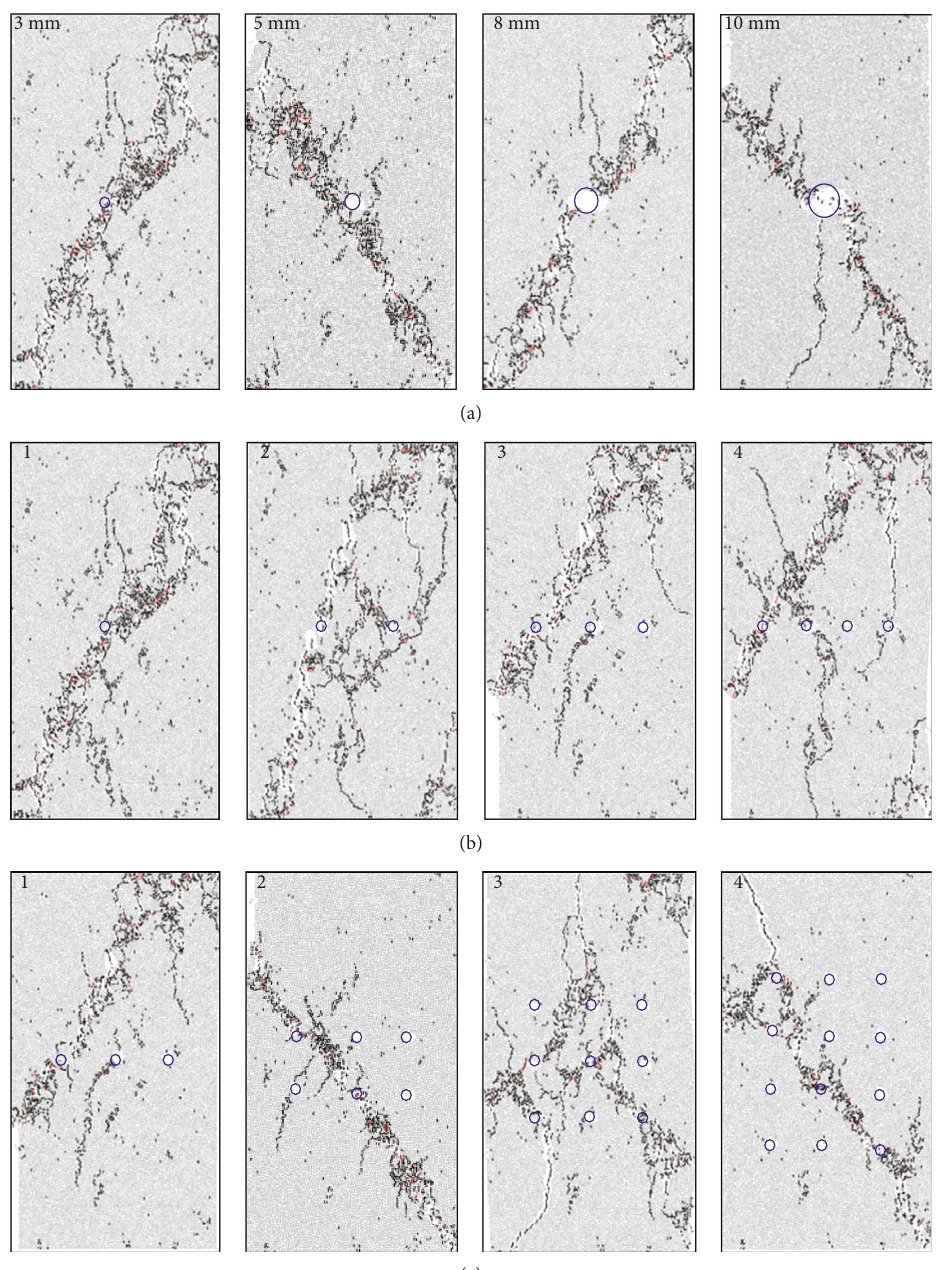
Figure 9: Failure modes of specimens with various drilling arrangements. (a) Different drilling diameters. (b) Different numbers of drilling holes in one row. (c) Different numbers of drilling